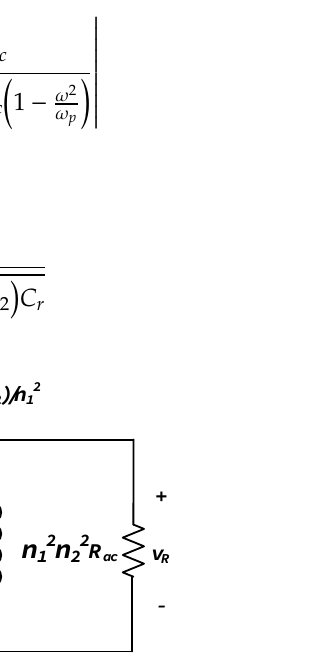
Figure 7. Equivalent circuit for the proposed CCWPT system.